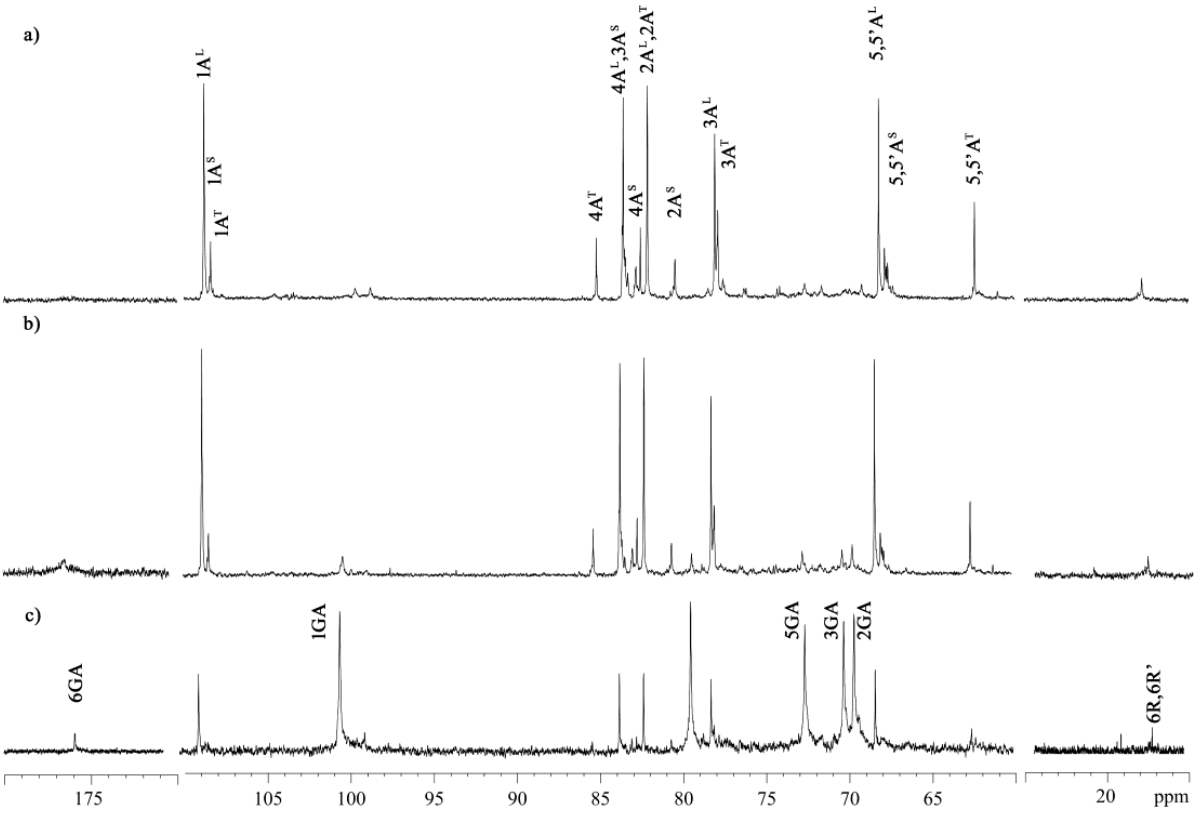
Figure 2. 13 C spectra of the SO1-1 ( a ), SO1-2 ( b ) and SO1-3 ( c ).